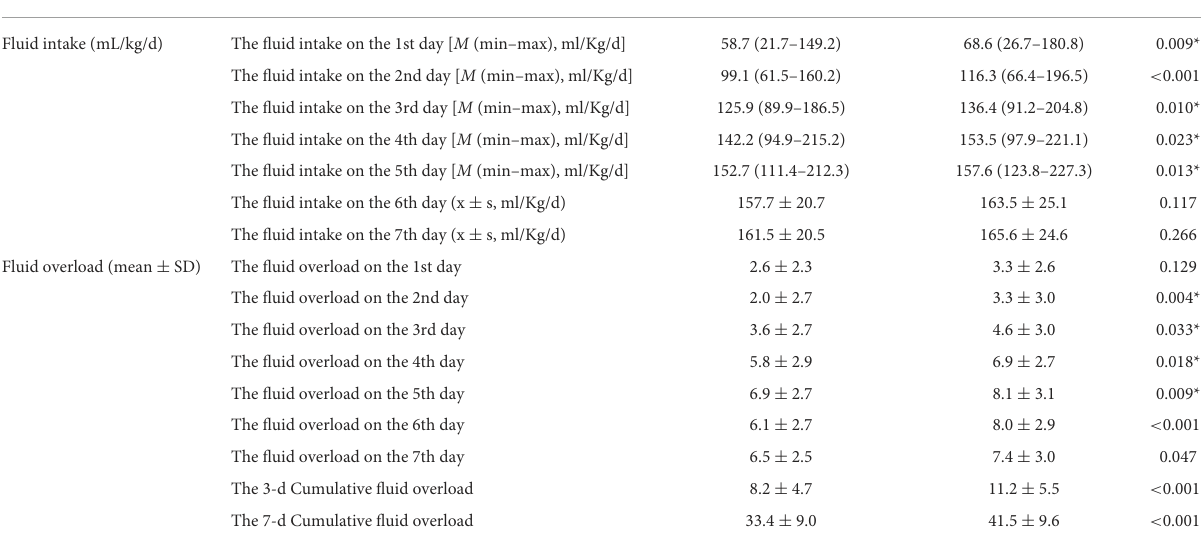
TABLE 3 Comparison of the fluid intake and overload within 7 days between the two groups of VLBWI. The non-BPD group (97) The BPD group (60) P